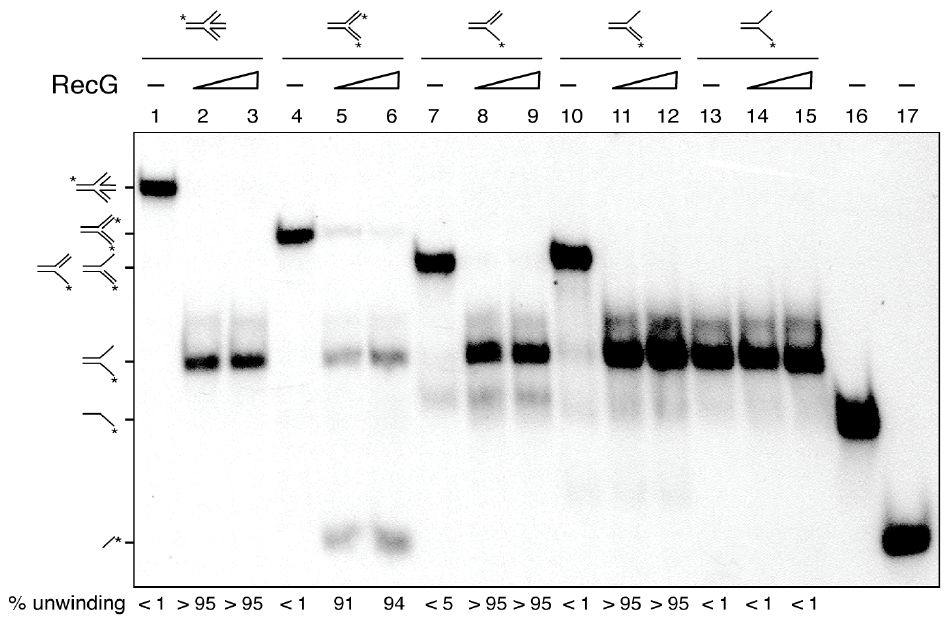
Figure 2. RecG unwinds HJs and nascent DNA strands from partial and complete replication fork substrates. The different radiolabeled DNA substrates (HJ-J4, Y fork, 5´-fork, 3´-fork or flayed DNA) were incubated with increasing RecG (15 and 30 nM) concentrations in buffer C containing 5 mM ATP (15 min at 37 °C). After deproteinization, substrates and products were separated by 6% PAGE in TAE buffer and analyzed by auto-radiography. The radiolabeled strands are indicated with an asterisk. In lanes 16 and 17 the [ γ 32 P]-labelled oligonucleotides are loaded as controls. A representative gel and below the mean ± SD of 3 independent experiments is shown.